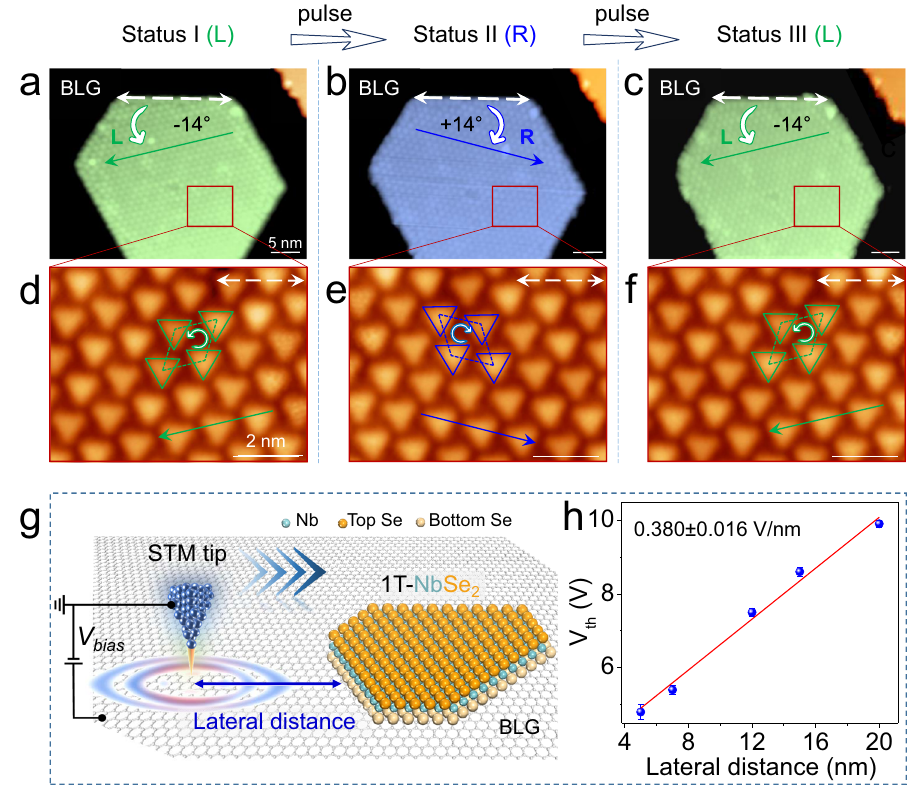
Fig. 4 Reversible switching of chiral CDW superlattice induced by an external electric fi eld. a – c Large-scale STM images of the reversible switching of chiral CDW superlattice of a 1T-NbSe 2 island, realized by applying voltage pulses. Two CDW close-packed directions are represented by green and blue arrows, respectively, which are rotated around ±14° with respect to the island edges (labeled by the white dashed double arrows). d – f Magni fi ed images of the areas in ( a – c ), showing the chirality identi fi ed by the relative arrangement of neighboring triangular SOD clusters. The top-layer Se close-packed direction is marked by the black dashed-arrow. g Schematic of the experimental setup. The bias voltage is applied between the tip and the substrate to form an external electric fi eld. h V th (magnitude of threshold voltage to switch the chirality of CDW) as a function of the lateral distance. The linear fi t indicates an electric fi eld effect (0.380 ± 0.016 V/nm) during the chirality switching. The error bar on each point gives the deviation from multiple measurements, which is too small to display. Scanning parameters: a – f , − 1.5 V, 20